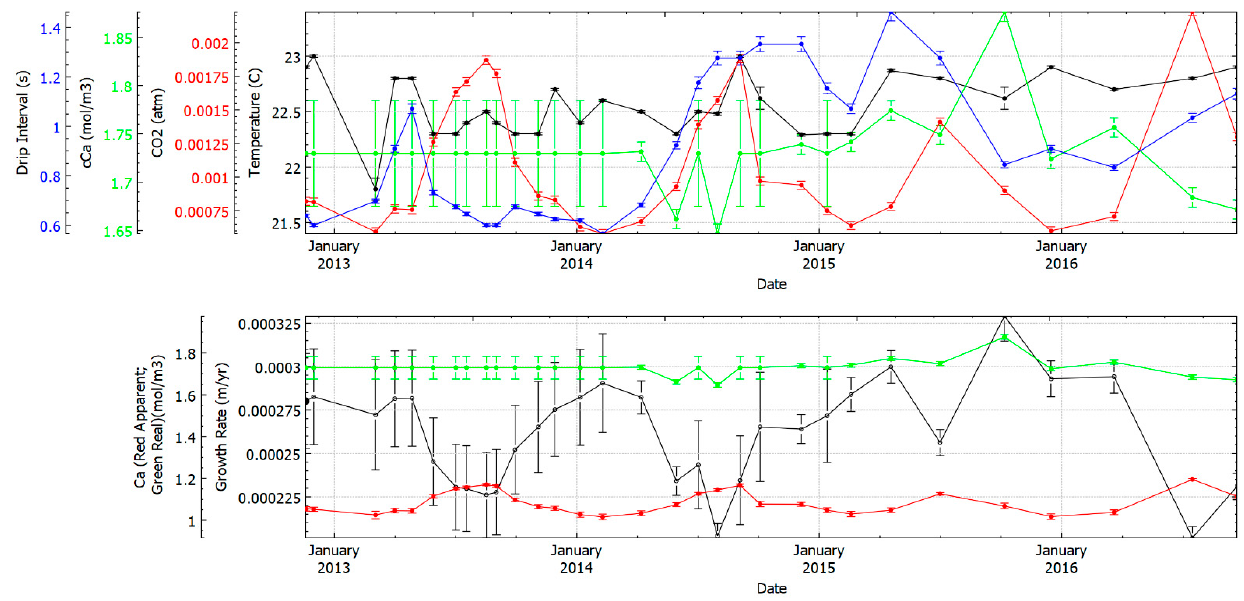
Figure 5. StalGrowth applied to Larga Cave drip site LA4. The top plot shows the input parameters and the bottom plot shows the output of StalGrowth (see Figure 1 for more detail).